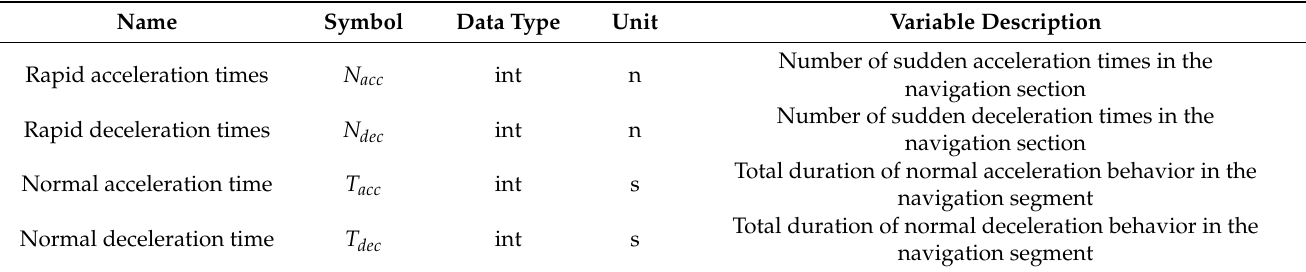
Table 3. Number of rapid acceleration and rapid deceleration times and duration of normal accelera- tion and normal deceleration to obtain the intermediate variables of the